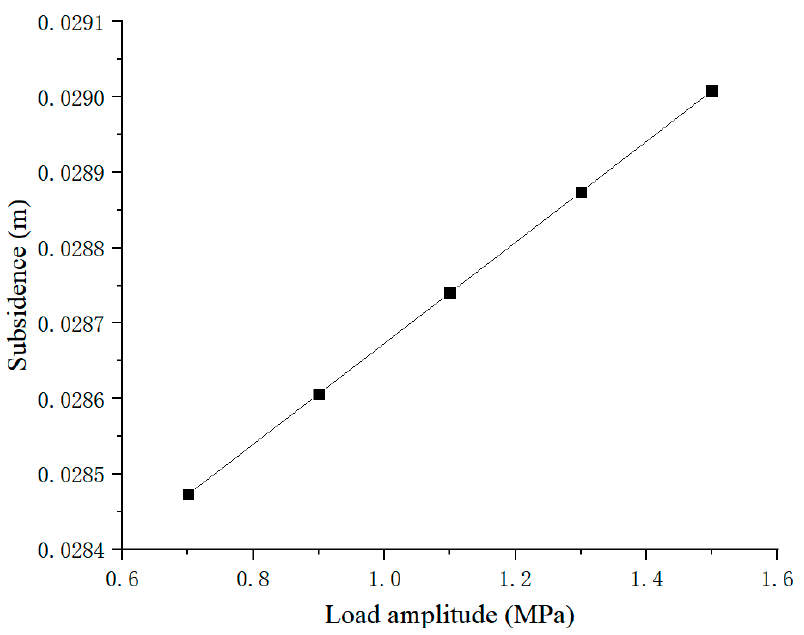
Figure 12. Variation of wall subsidence at 14.625 m under different load amplitudes.